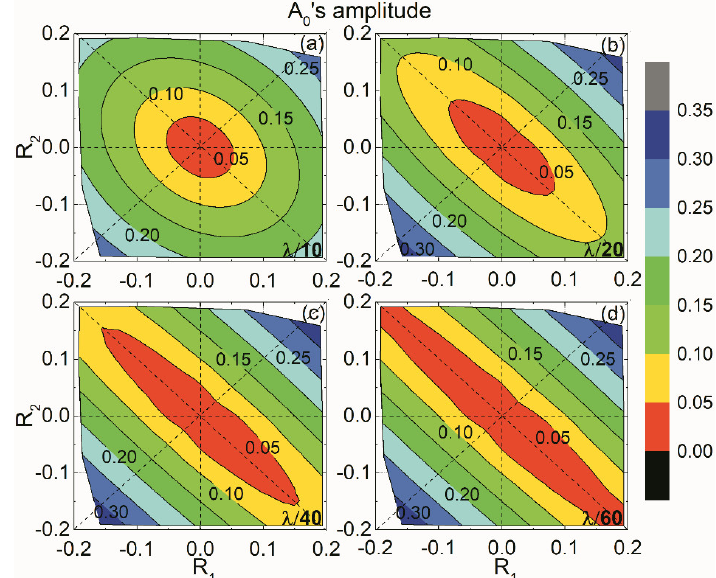
Figure 10. A 0 ’s amplitude of 120 thin-bed models with different thickness, R 1 or R 2 .